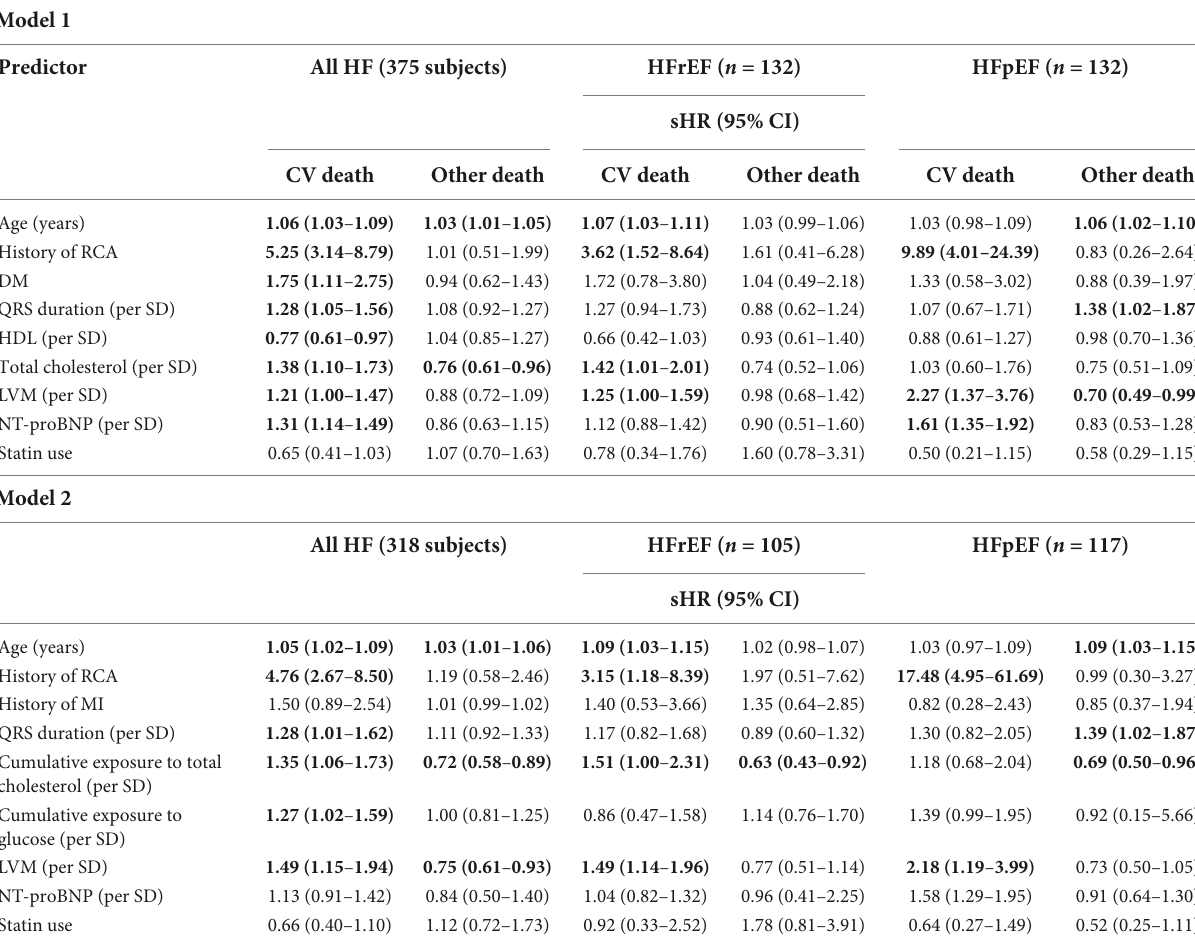
TABLE 2 The association between time-to-CV mortality and selected variables in participants with incident